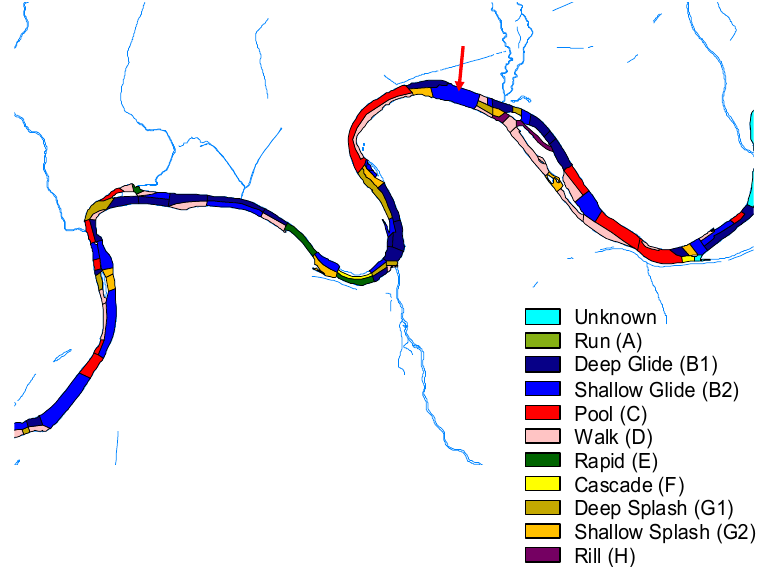
Figure 8. A section of the Orkla river mapped by the classification system described by [39]. The arrow indicates the position of the Syrstad gauge located in a shallow glide, which shows frazil ice accumulation over winter.